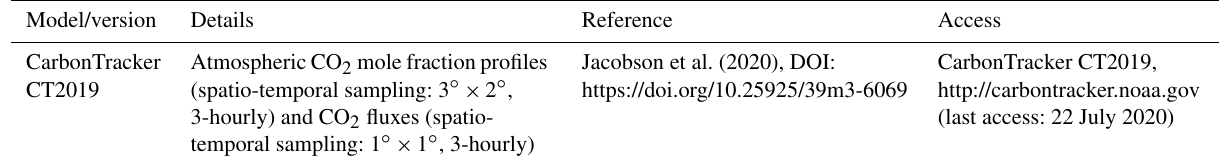
Table 2. Overview of the CarbonTracker CT2019 data set. For this study we used data from the period January 2015 to December 2018.